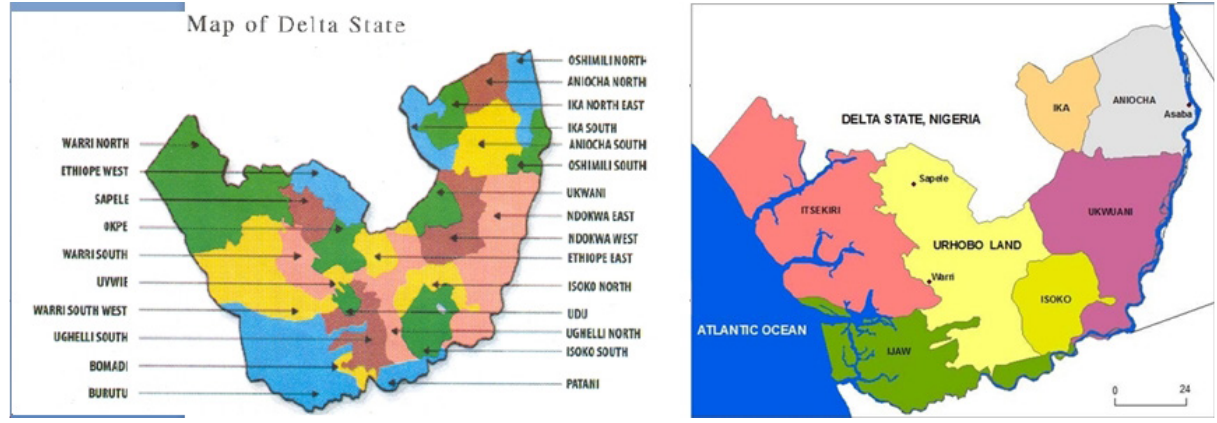
Figure 2: The map of Delta state showing the study area; Source: Wikipedia, 2017